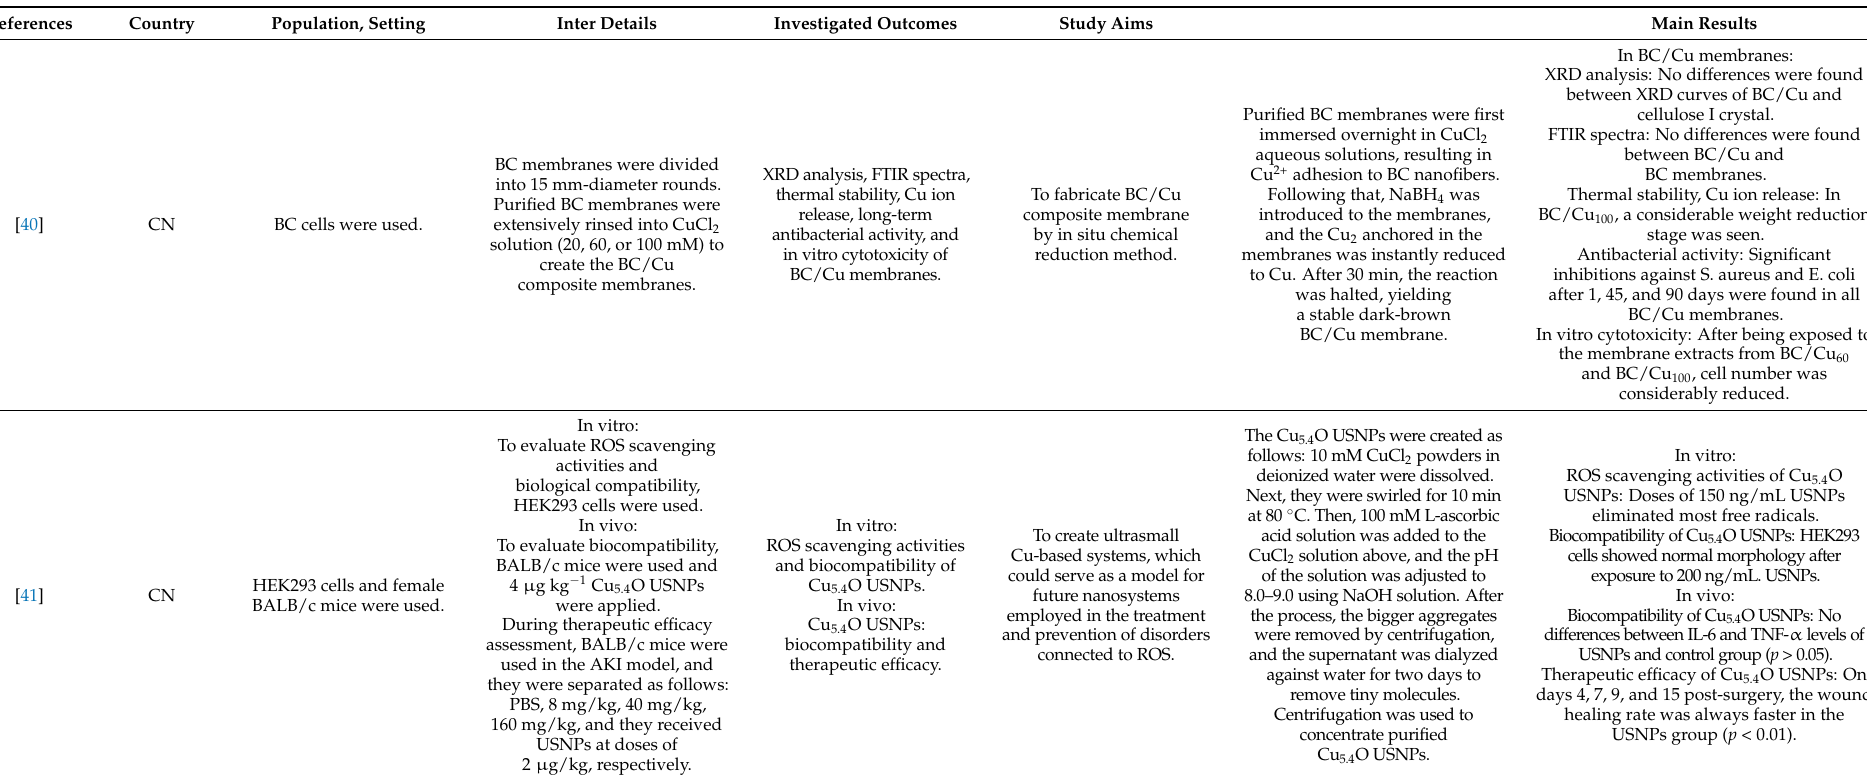
Table 1. Characteristics of included